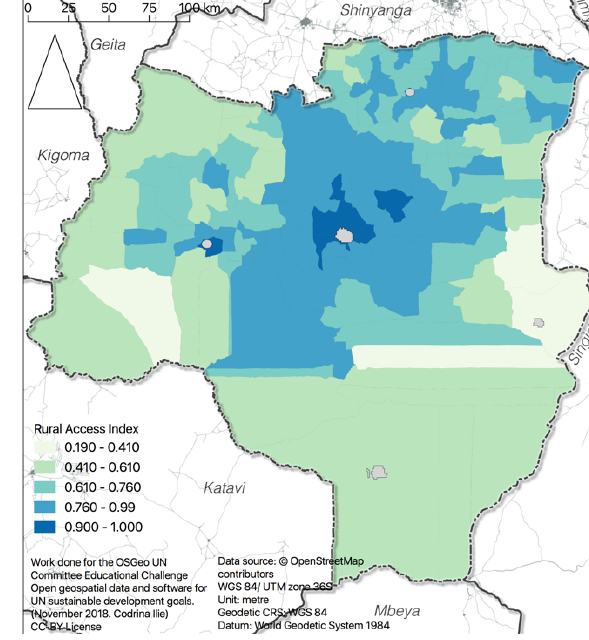
Figure 4. RAI for the Tabora region in